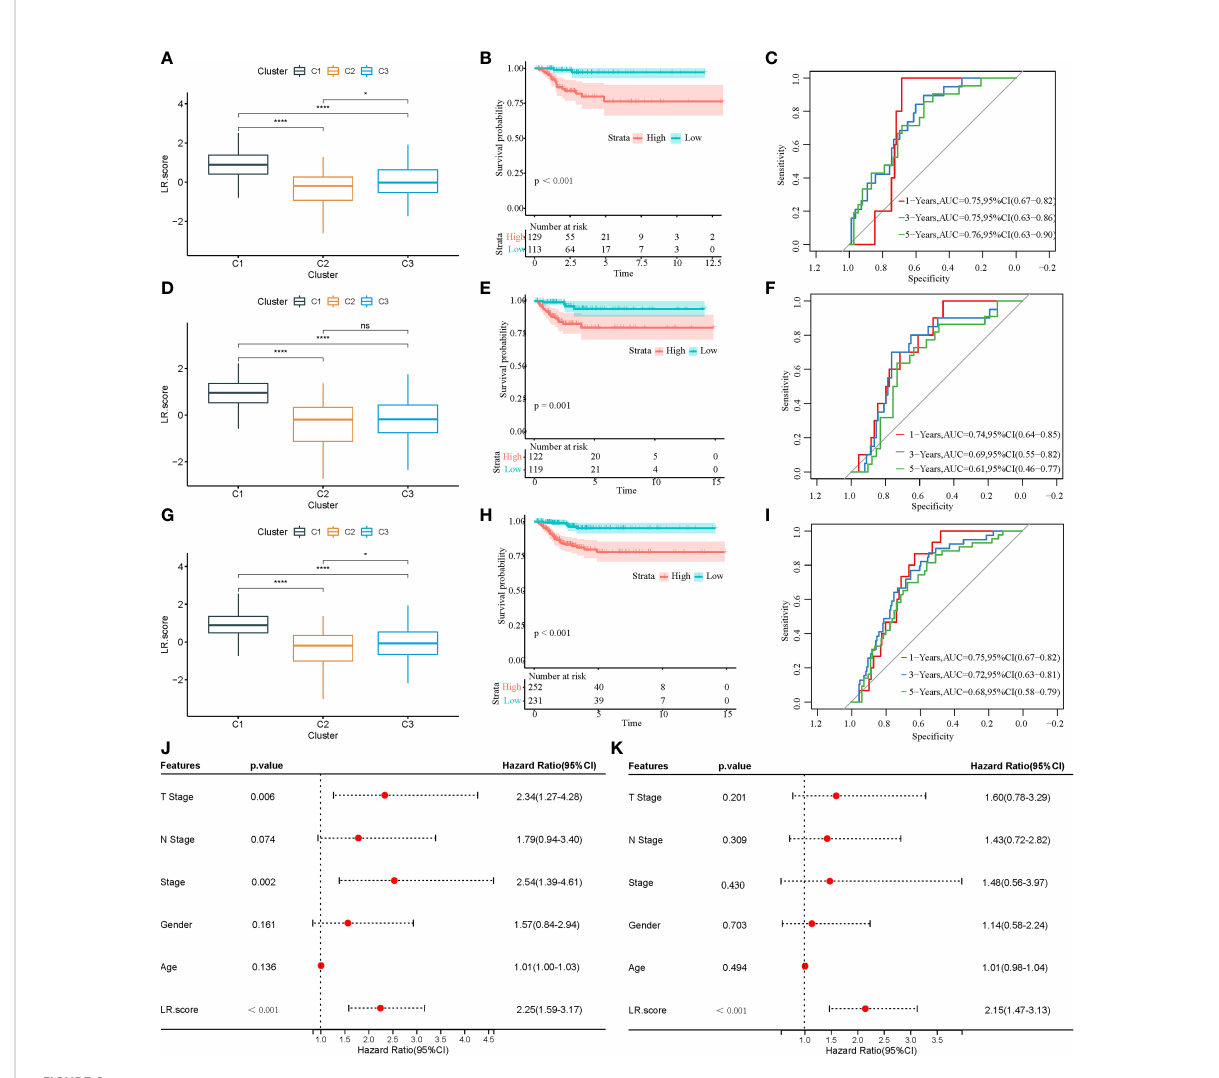
FIGURE 8 (A) LR.score differences in different subtypes in the training set. (B) Survival analysis between high and low LR.score groups in the training set. (C) The predictive value of LR.score in 1-, 3-, and 5-year overall survival in the training set. (D) LR.score differences in different subtypes in the test set. (E) Survival analysis between high and low LR.score groups in the test set. (F) The predictive value of LR.score in 1-, 3-, and 5-year overall survival in the test set. (G) LR.score differences in different subtypes in the entire dataset. (H) Survival analysis between high and low LR.score groups in the entire dataset. (I) The predictive value of LR.score in 1-, 3-, and 5-year overall survival in the entire dataset. (J) Univariate Cox regression model analysis. (K) Multivariate Cox regression model